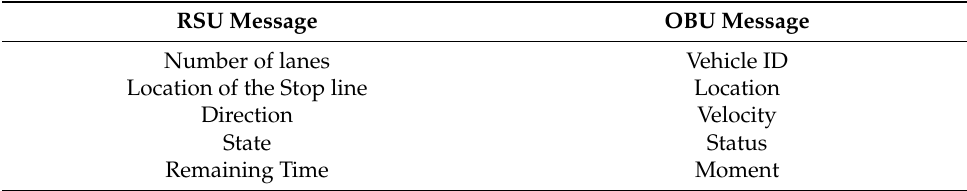
Table 1. Messages defined for RSU and OBU.